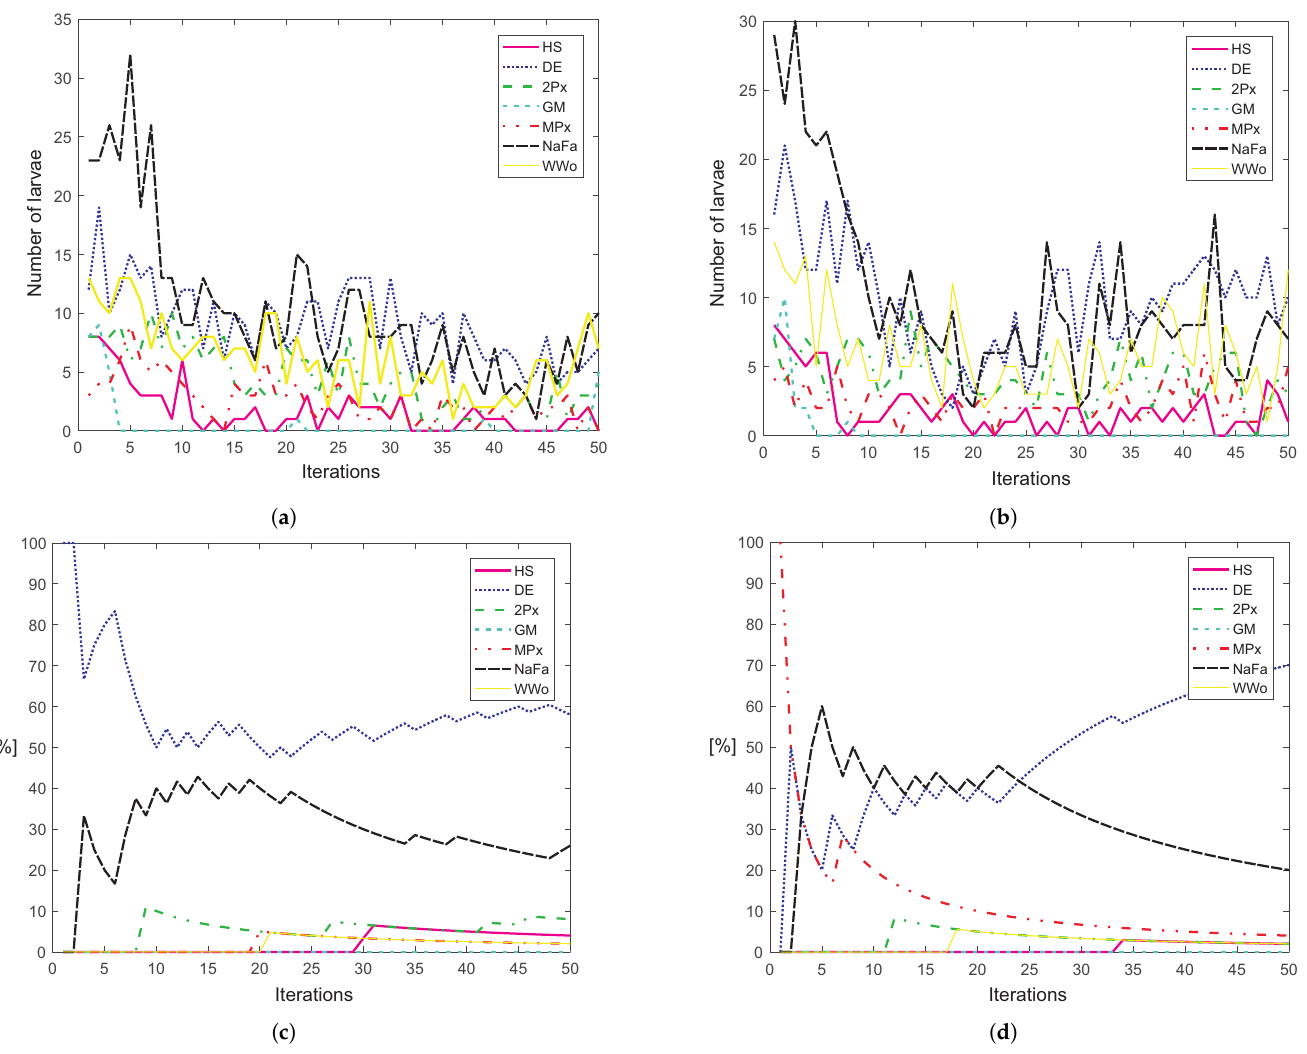
Figure 10. Number of larvae entering to the reef per substrate for the linear ( a ) and nonlinear ( b ) cases, and ratio of times that each substrate generates the best larva in the linear ( c ) and nonlinear ( d ) cases when the span B is fixed.